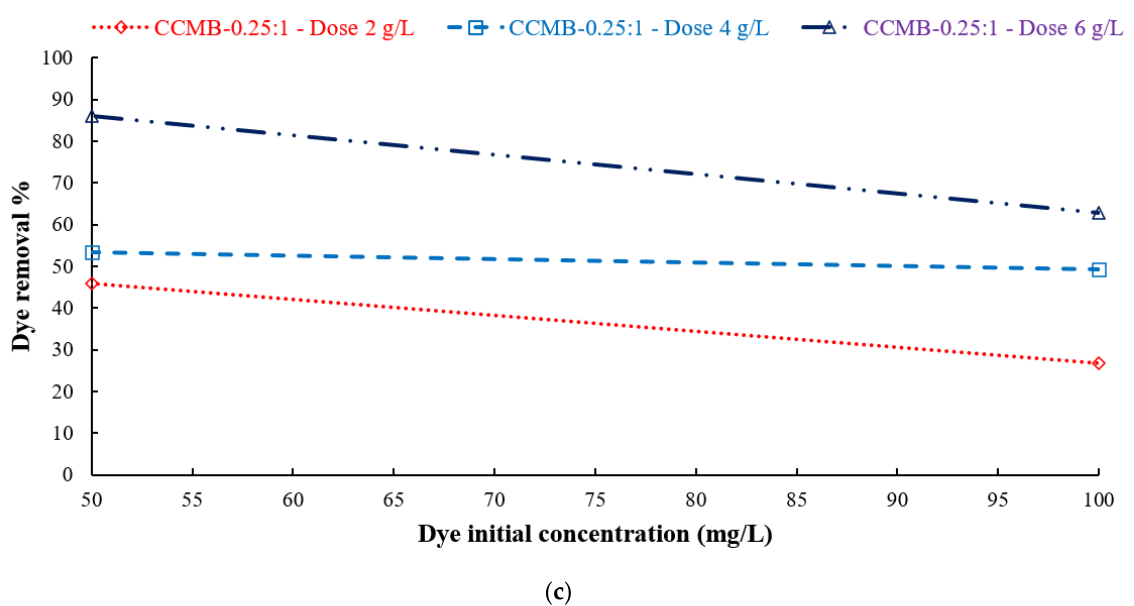
Figure 17. Effect of dye initial concentration on removal efficiency using different adsorbents: ( a ) chitosan, ( b ) nanocellulose, and ( c ) CCMB-0.25:1.